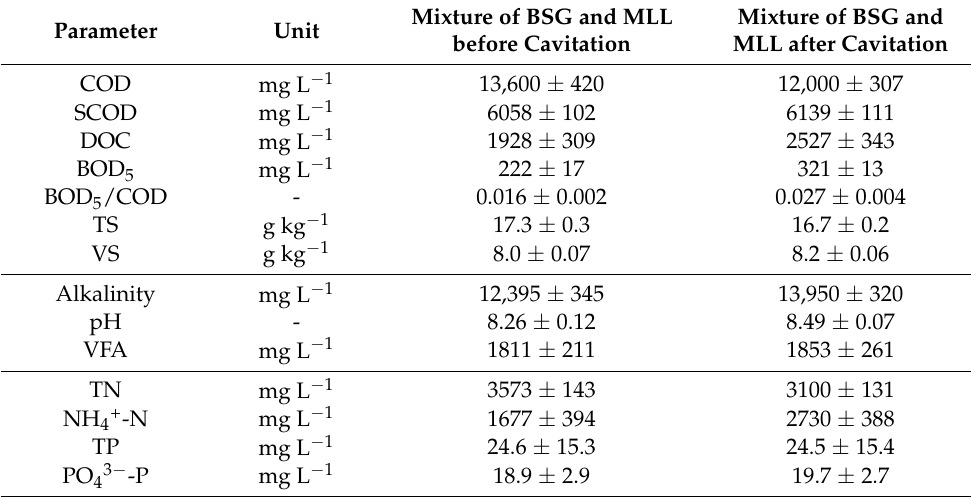
Table 3. Composition of BSG and MLL mixture before and after cavitation (average value ± standard deviation are